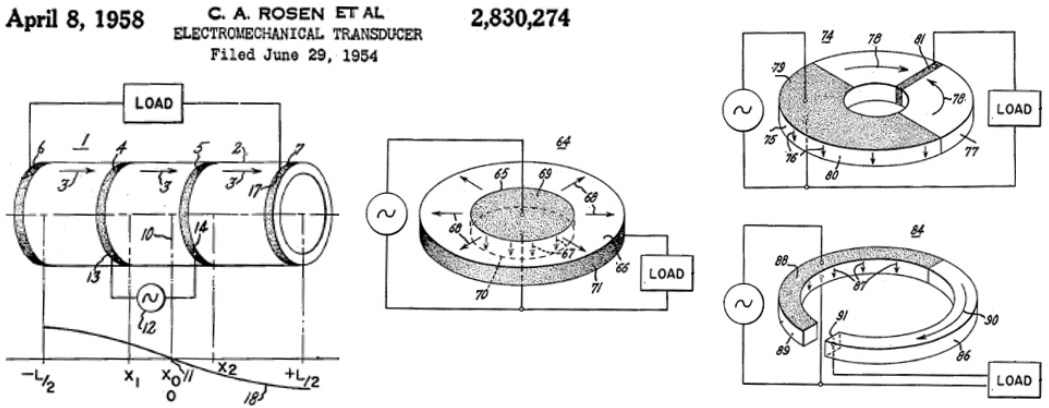
Figure 4. Other piezoelectric transformer embodiments presented by Rosen in 1954 [13].